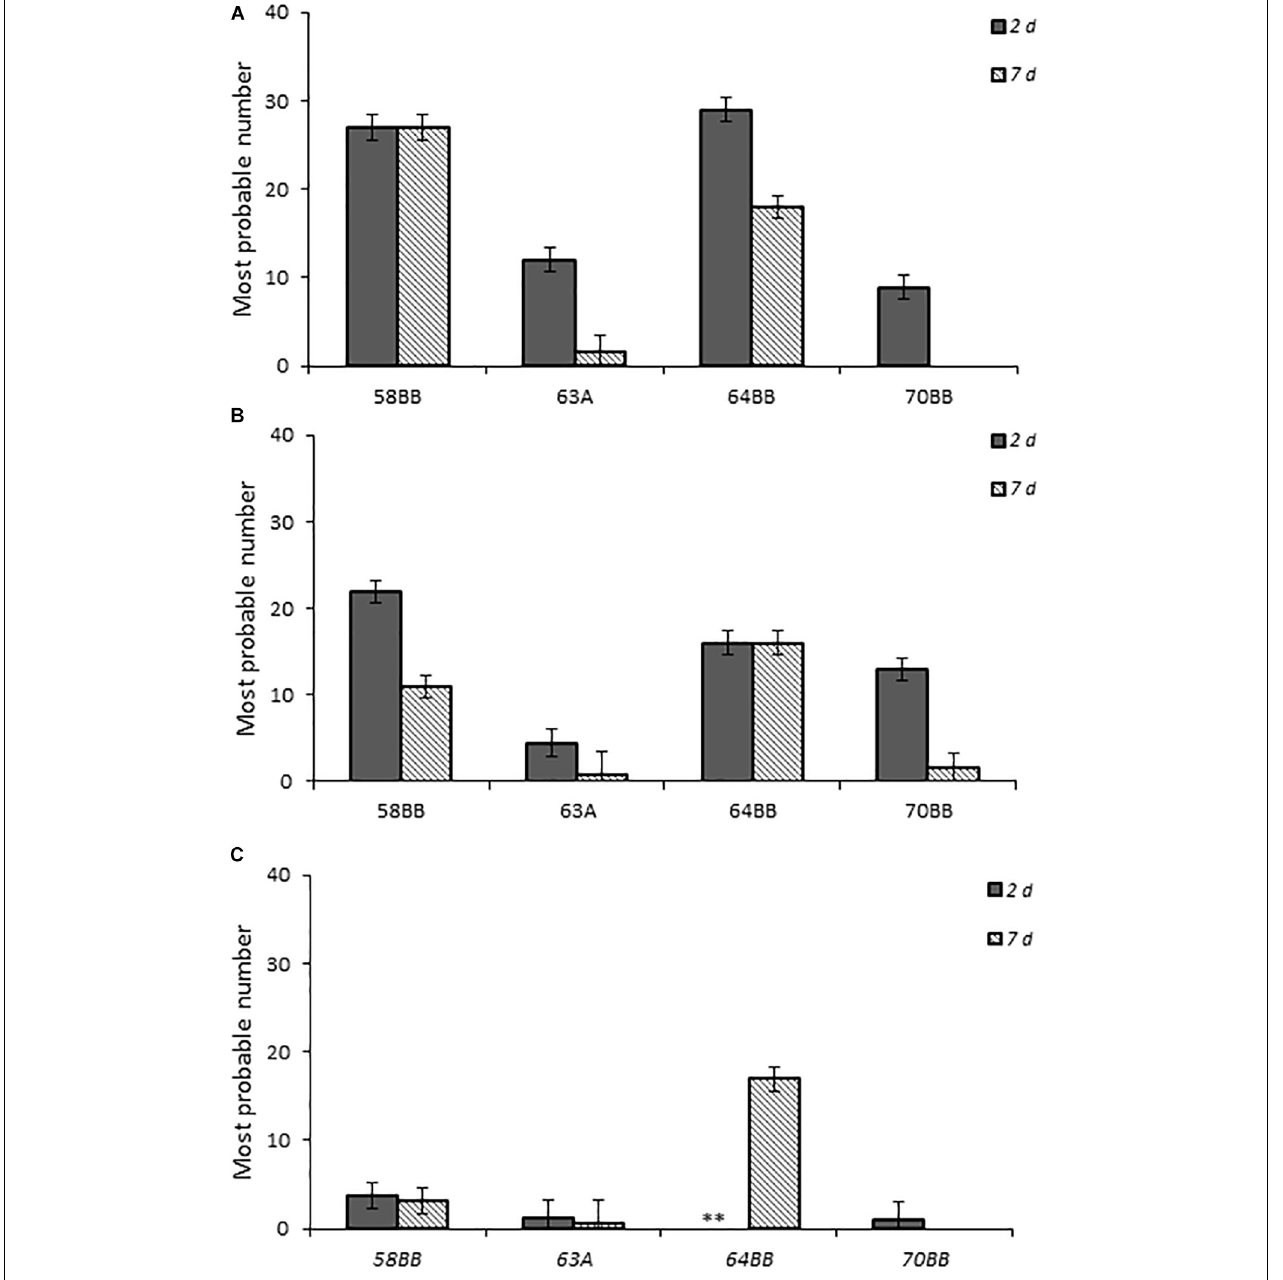
FIGURE 5 | Fecal bacterial burden in chicks infected with Campylobacter jejuni . Environmental isolates at doses (A–C) , respectively, as determined by the most probable number (MPN) calculations as described in section “Materials and